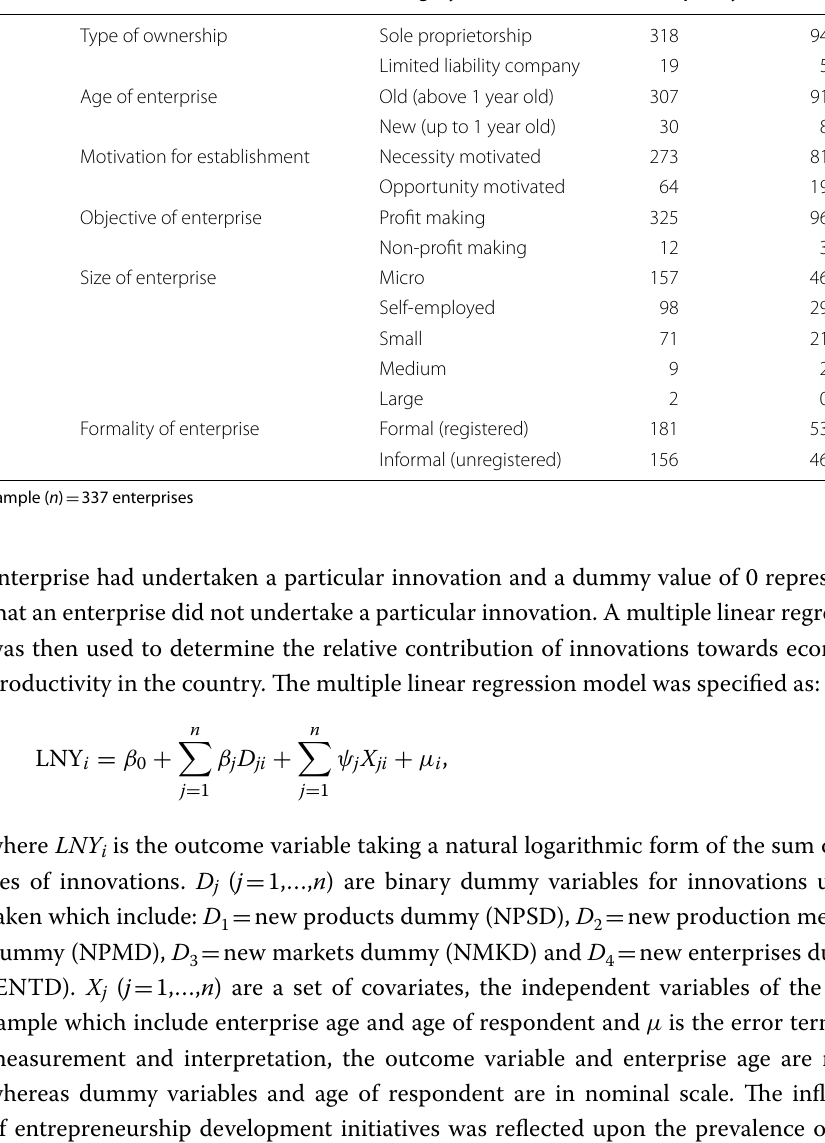
Table 1 Results of statistical descriptive analyses of enterprises studied